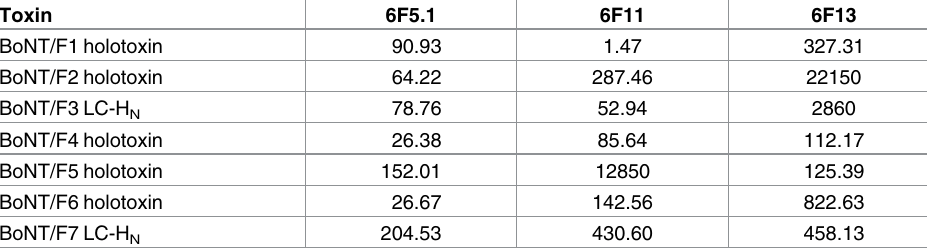
Table 3. K D values of selected IgGs to BoNT/F toxin subtypes (x 10 − 12 M) as determined by flow fluorimetry in a KinExA